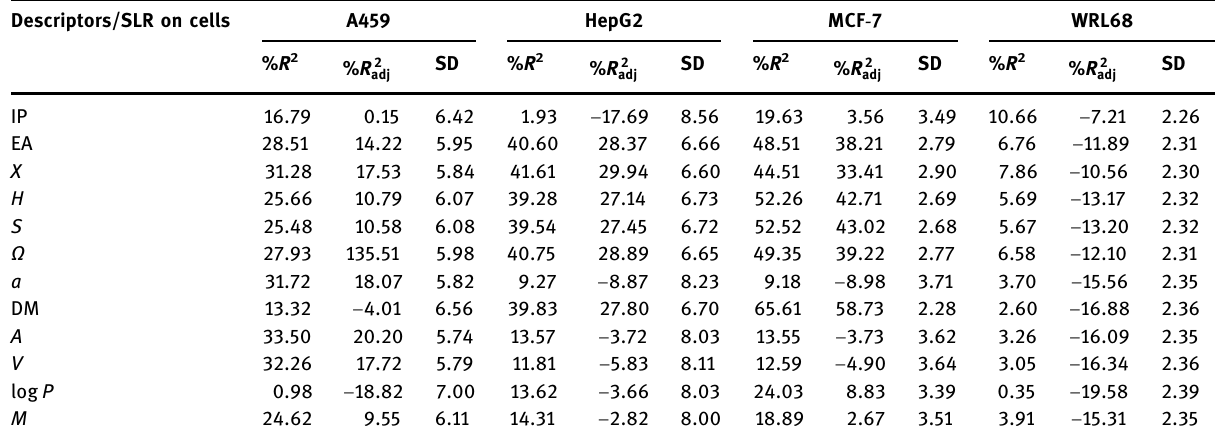
Table 7: Correlation coe ffi cients ( R 2 ) , adjusted correlation coe ffi cients ( ) R adj2 , and SDs of SLR between chosen descriptor and cell lines considering compounds 2g – 2m Descriptors/SLR on